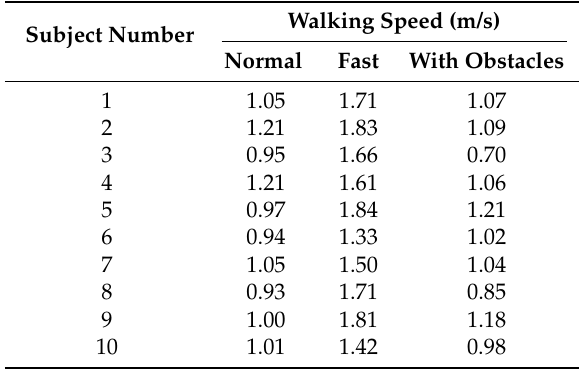
Table 2. Subject average speed during each walking